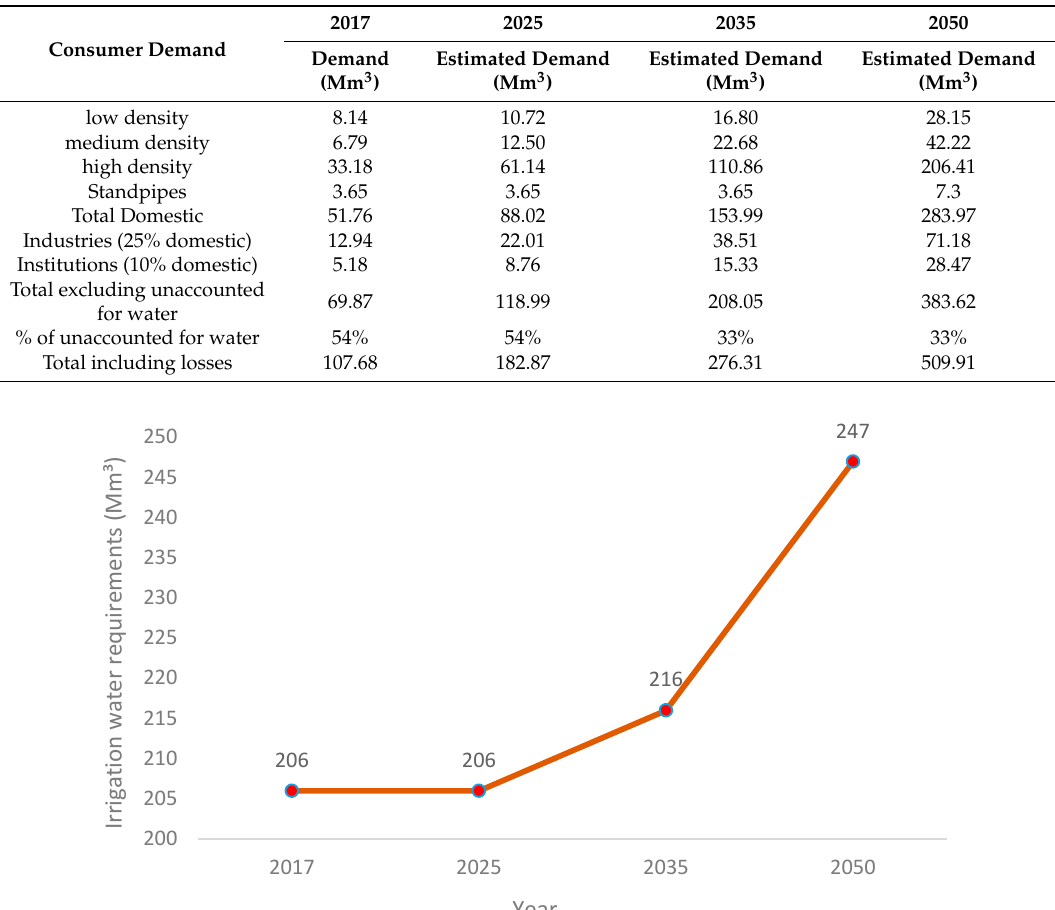
Figure 4. Population and water demand projection of Kano Metropolis. Table 2. Estimated present and projected water demand for Kano city.